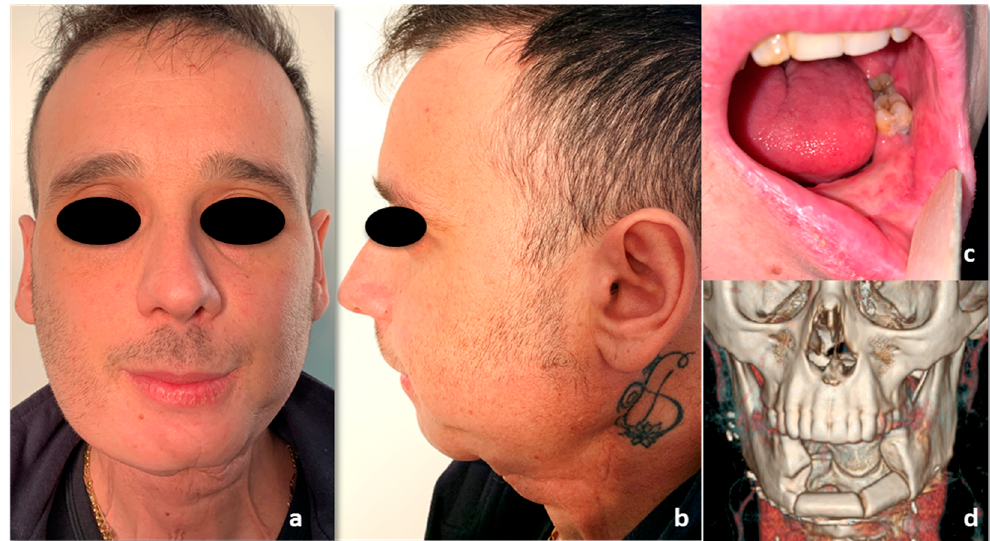
Figure 13. Thirty-one-months follow-up. ( a ) Frontal view. ( b ) side view. ( c ) intraoral picture. ( d ) 3D CT reconstruction.